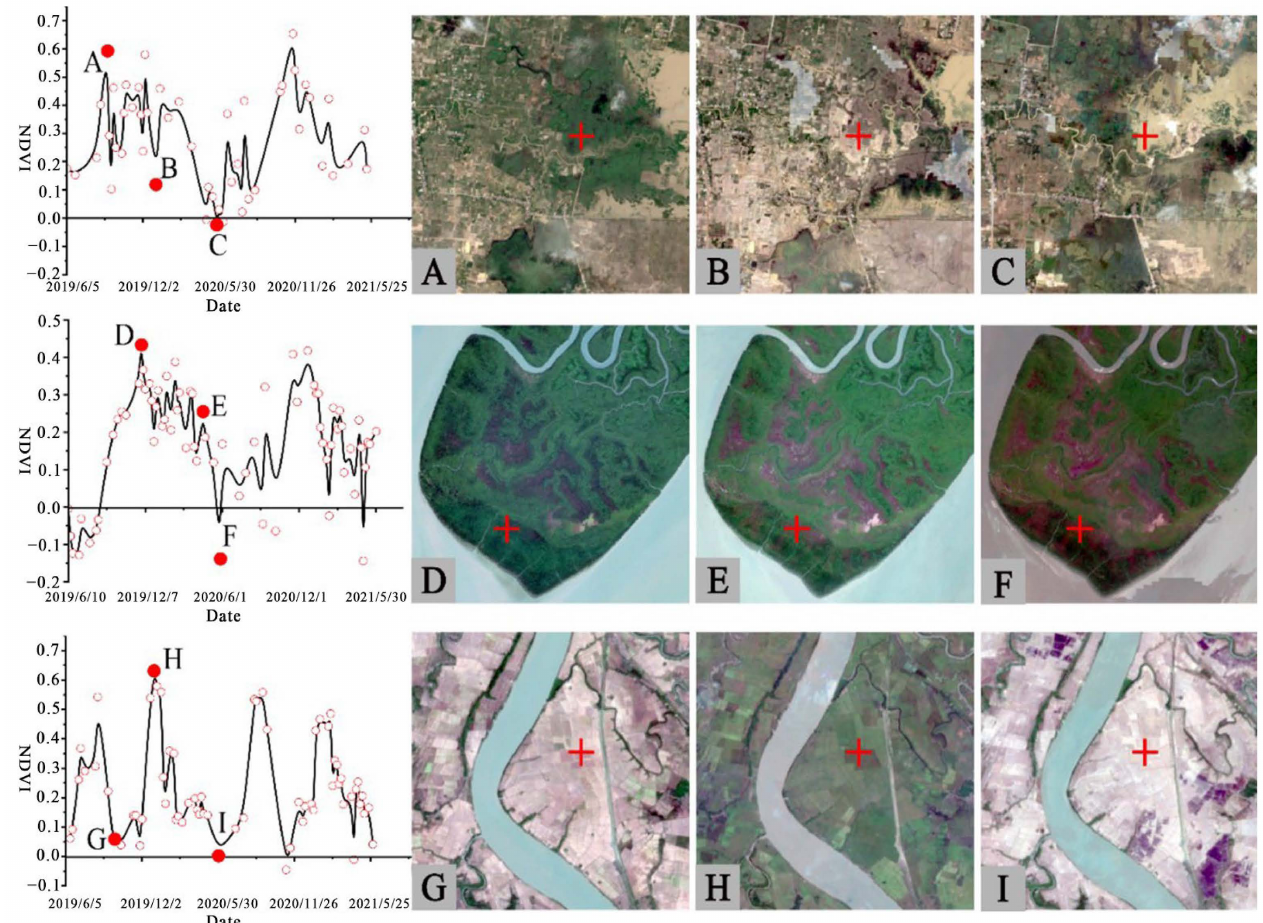
Figure 6. Mixed vegetation and waterbody wetlands phenological features: ( A – C ) are the NDVI values and Sentinel-2 images of inland swamp at the maximum green degree time, end of the growing season, and end of the season, respectively. ( D – F ) are the NDVI values and Sentinel-2 images of coastal swamp at the maximum green degree time, end of the growing season, and end of the season, respectively. ( G – I ) are the NDVI values and Sentinel-2 images of agricultural land at the beginning of the growing season, maximum green degree time, and end of the growing season,